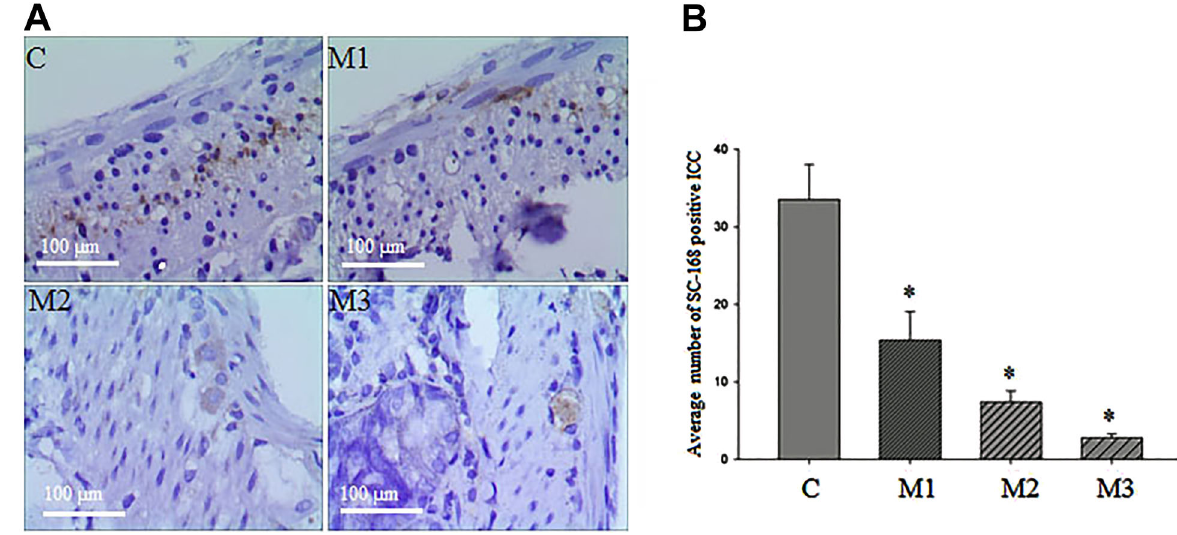
Figure 3. A , Immunohistochemical staining images of interstitial cells of Cajal (ICC) after intestinal obstruction (400 (cid:2) magni fi cation; bar, 100 m m). Intestinal tissues are from rats with sham-operation (C), one day obstruction (M1), two days obstruction (M2), and three days obstruction (M3). B , Histogram of average number of ICC after immunohistochemical staining. Results are reported as means ± SD. *P o 0.05 among the 4 groups (one-way ANOVA followed by Newman-Keuls